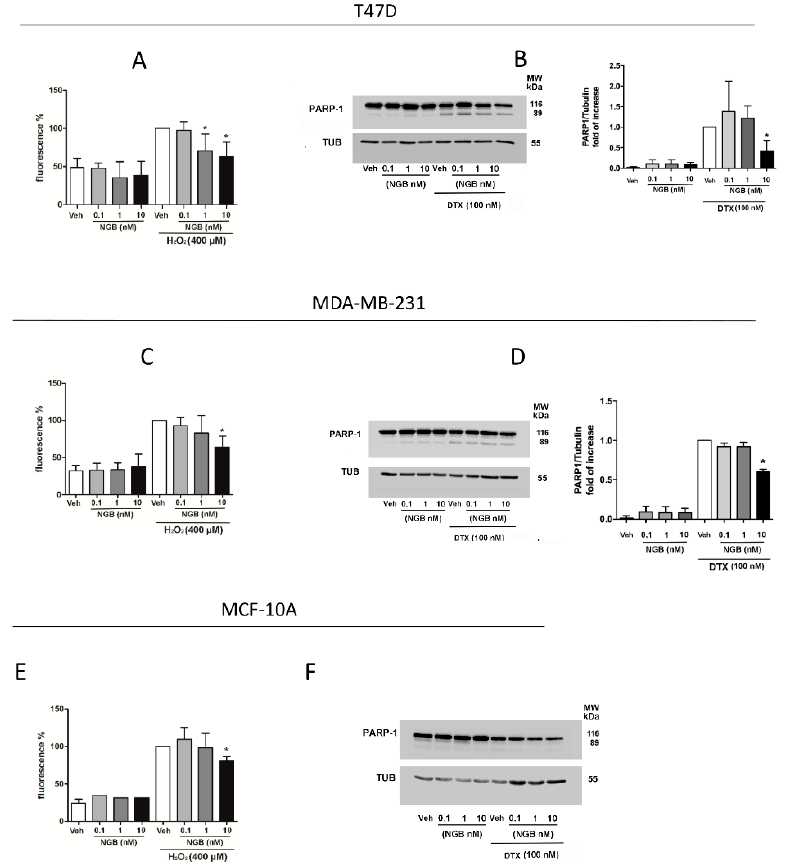
Figure 4. Effects of exogenous NGB on ER α +/ − breast cancer and non-tumorigenic